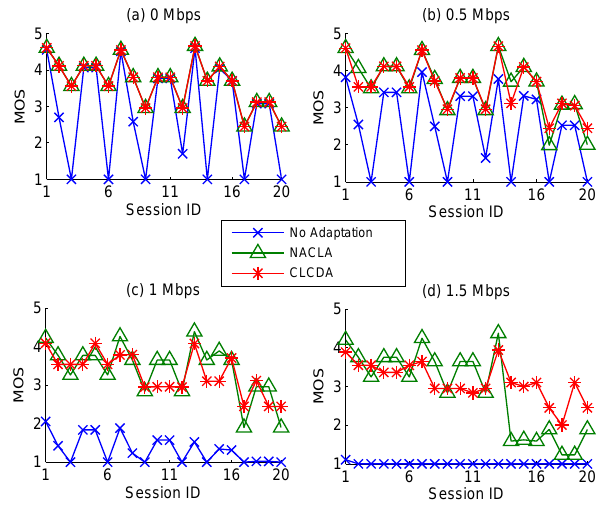
Figure 8. Evolution of MOS scores for different backhaul background traffic loads: (a) 0 Mbps, (b) 0.5 Mbps, (c) 1 Mbps,